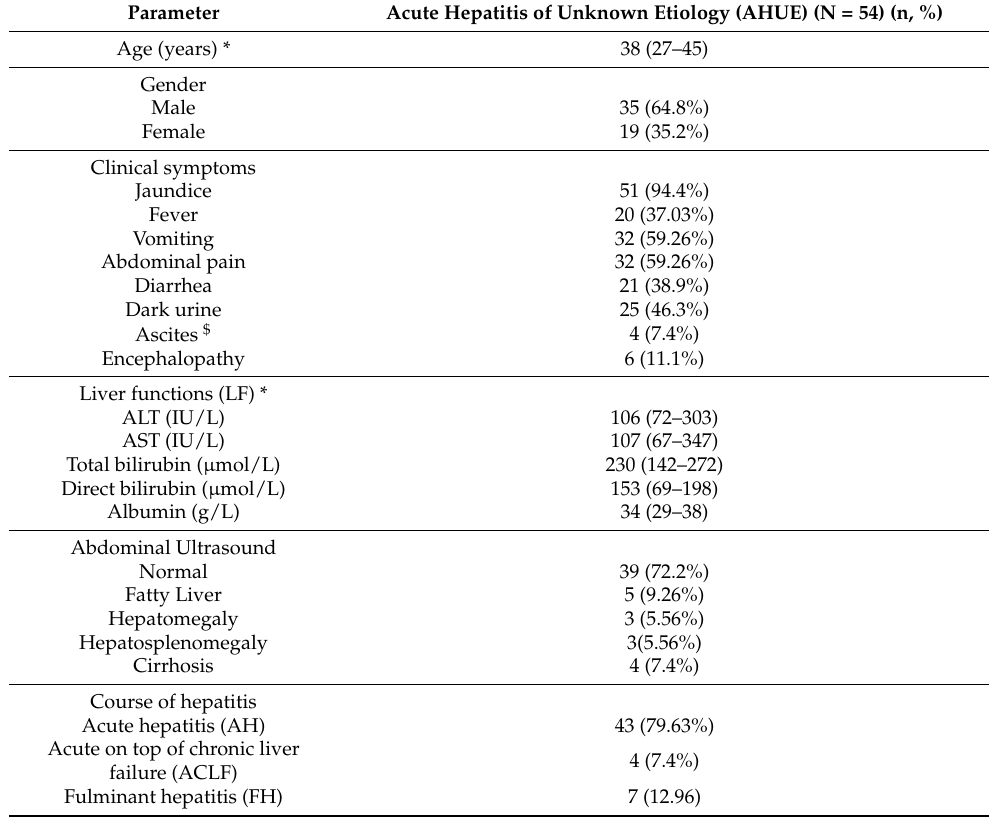
Table 1. Demographic, clinical, and laboratory parameters of acute hepatitis of unknown etiology